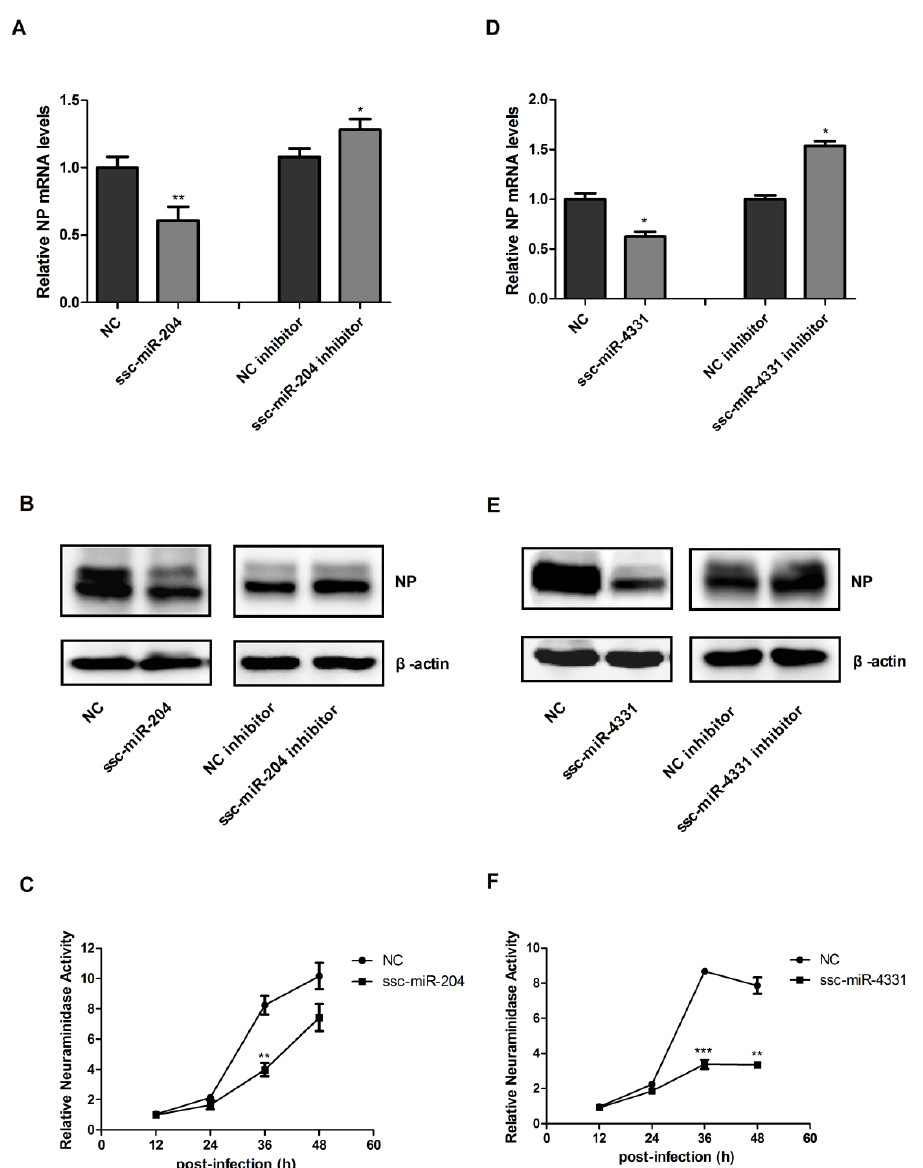
Figure 4. Ssc-miR-204 and ssc-miR-4331 inhibited SIV-H1N1/2009 replication. NPTr cells were transfected with ssc-miR-204/ssc-miR-4331 mimics or inhibitors for 24 h and then infected with SIV- H1N1/2009. The cells were collected at 36 h post-infection to detect the mRNA levels ( A , D ) and protein levels ( B , E ) of viral NP using qRT-PCR and western blotting respectively; ( C , F ) The neuraminidase activities of the supernatants were measured using a 2′-(4-methylumbelliferyl)-α- D